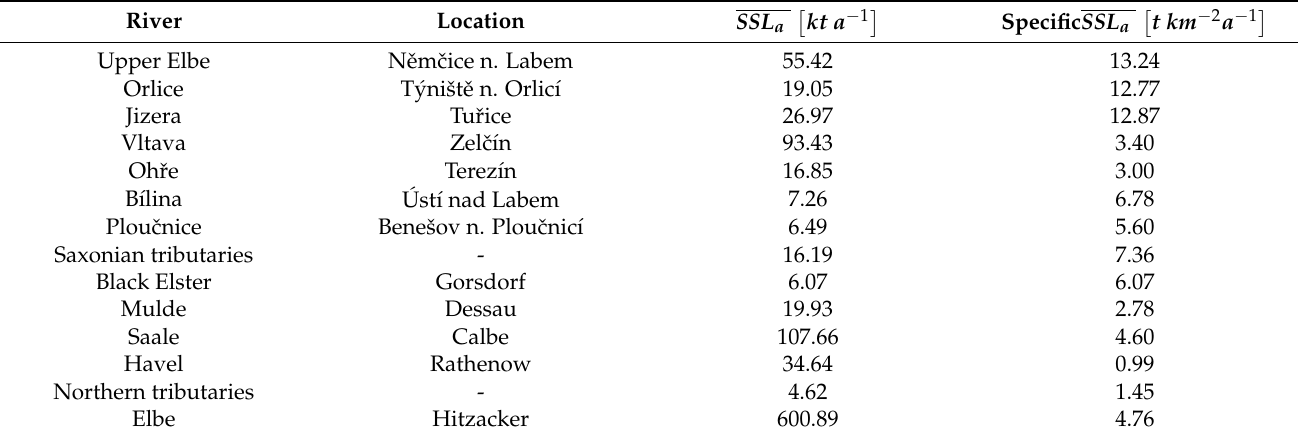
Table 2. Average annual suspended sediment loads ( SSL a ) and specific loads of the Elbe and its